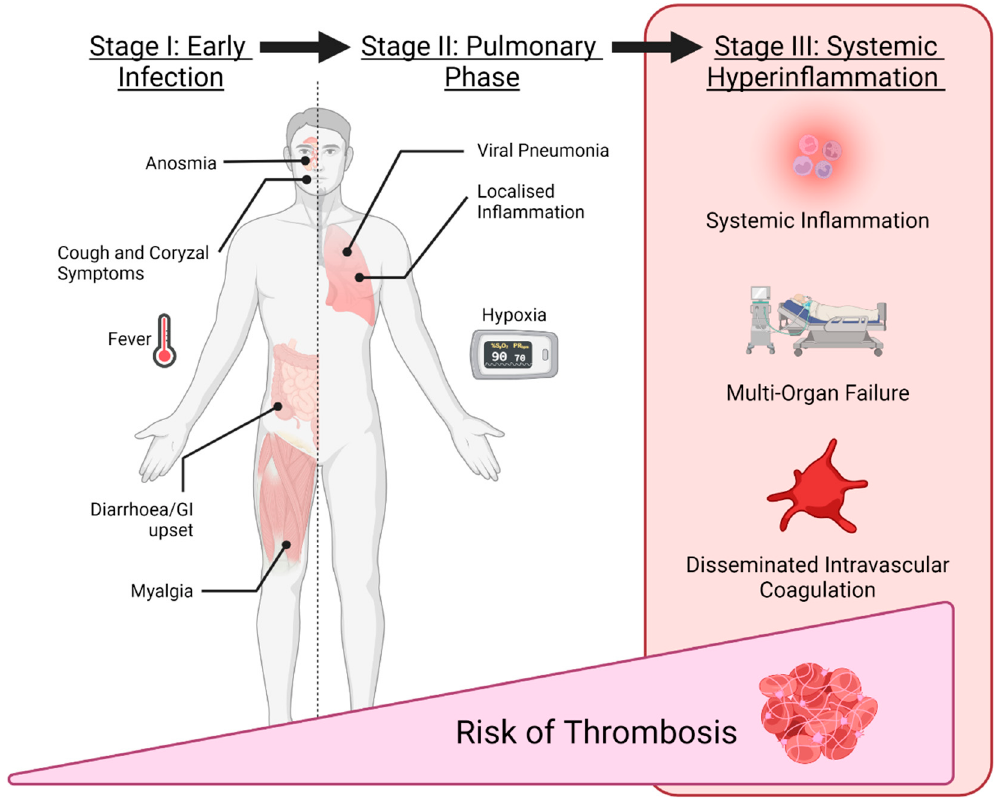
Figure 2. Typical stages of a COVID-19 infection and their clinical